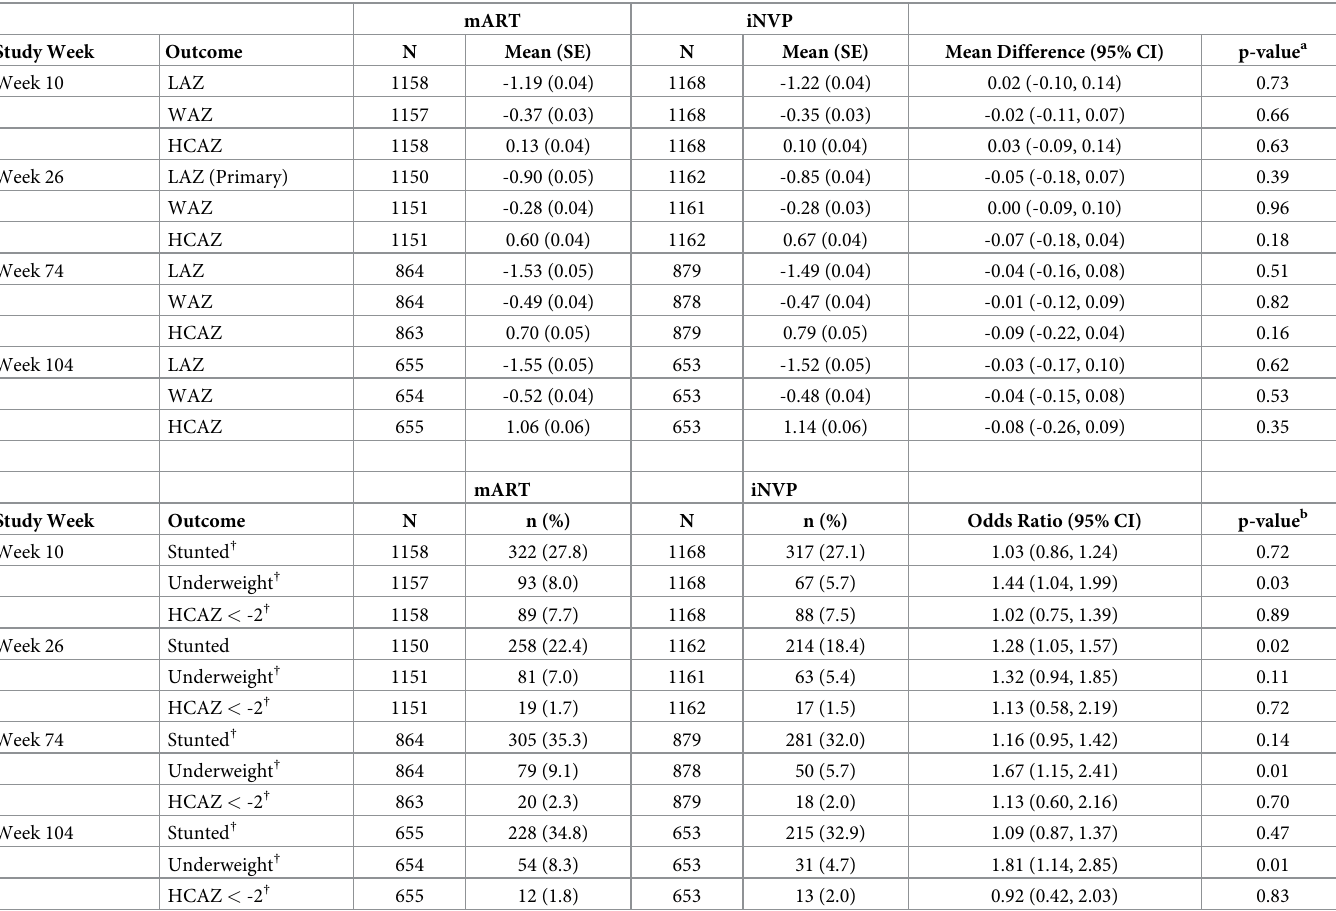
Table 2. Summary statistics and comparisons of infant growth measurements by Postpartum Component randomization.